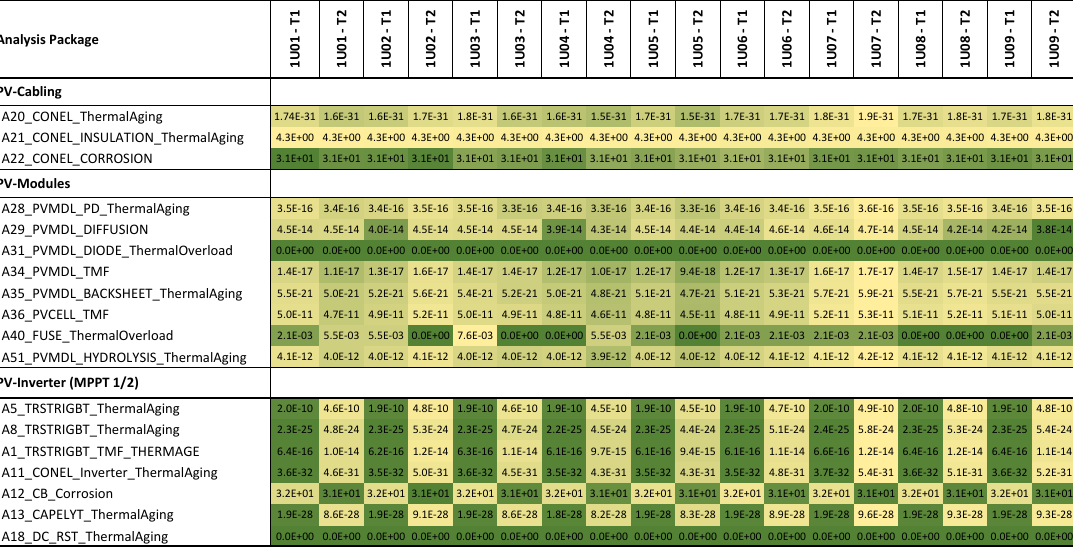
Figure A2. Damage calculation results for MPPTs “2U01 - T1”–“ 2U10- T2” . References 1.